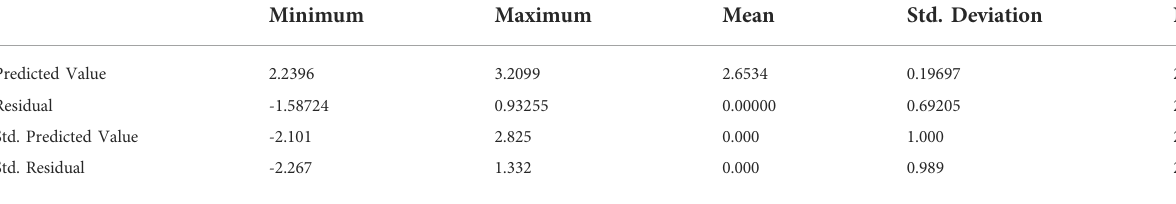
TABLE 7 Residual statistics corresponding to the dependent variable for Pic.